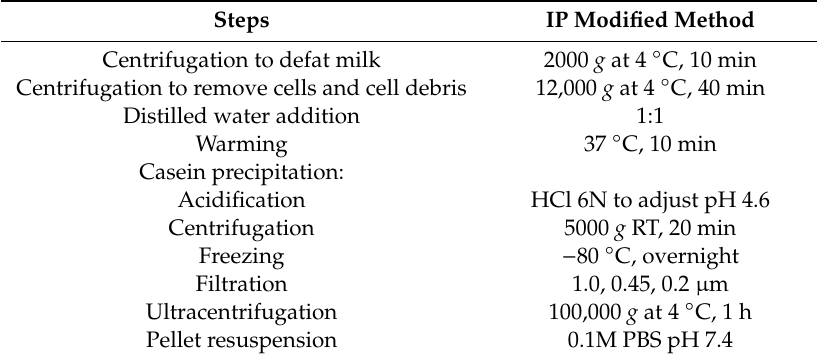
Table 3. Proposed method for isolating exosomes from raw